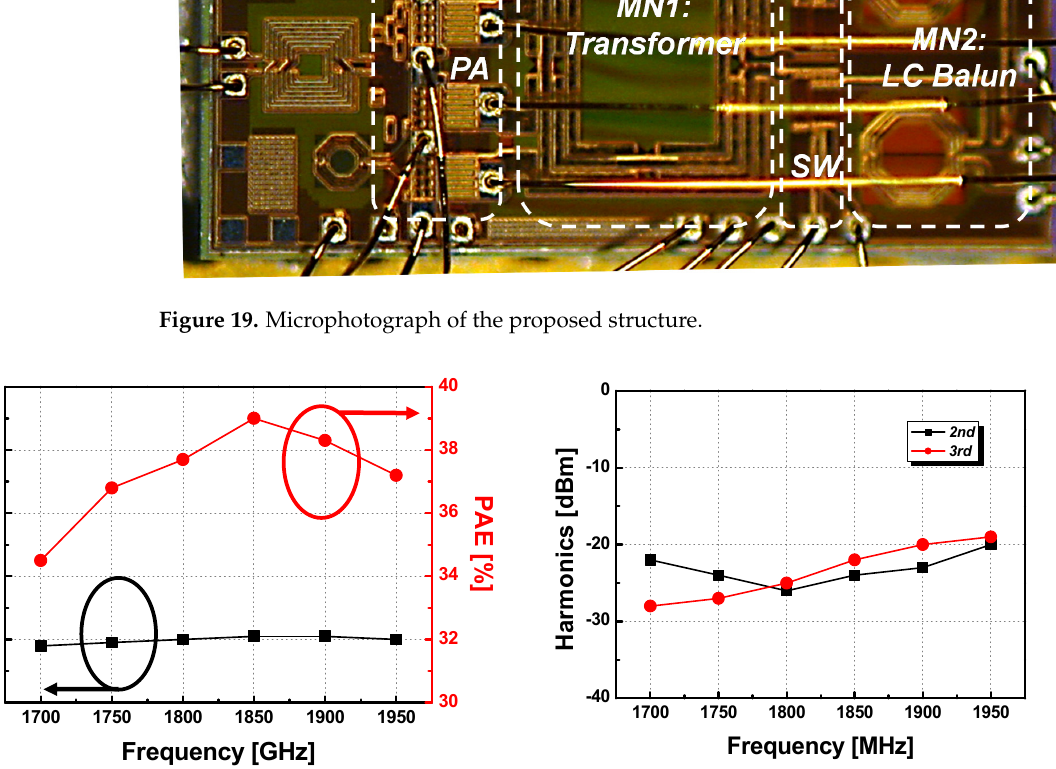
Figure 19. Microphotograph of the proposed structure.